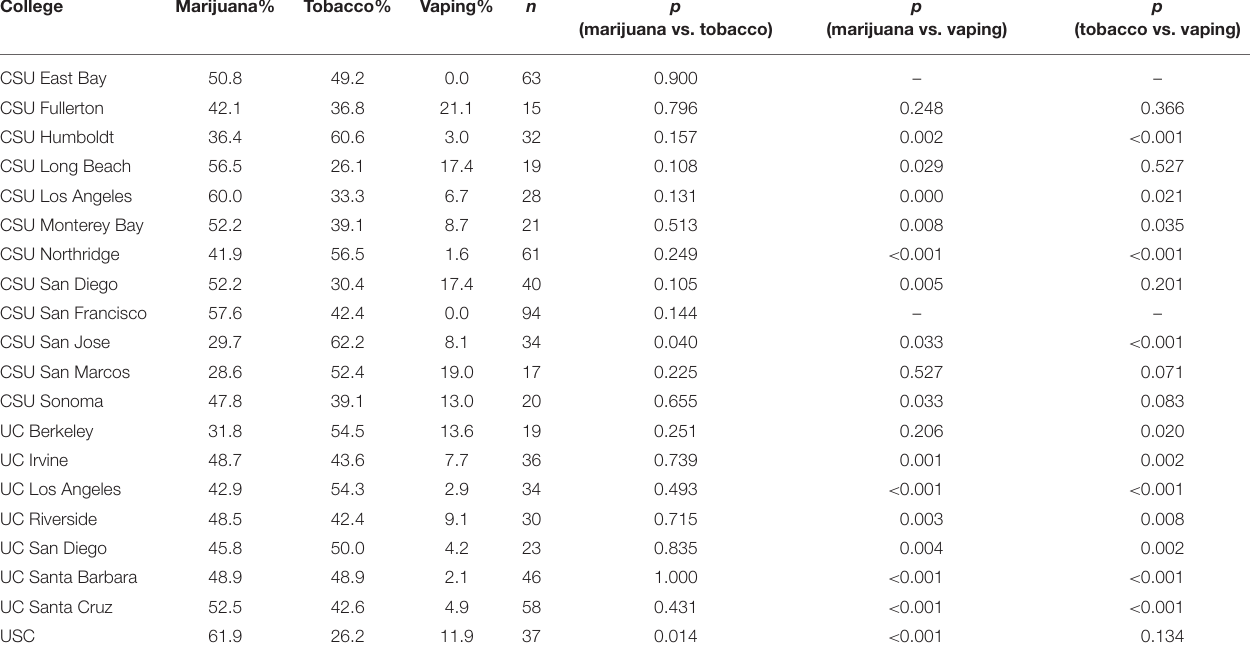
TABLE 1 | Proportional comparisons of product category by 4-year college, for top 20 campuses. College Marijuana% Tobacco% Vaping% n p